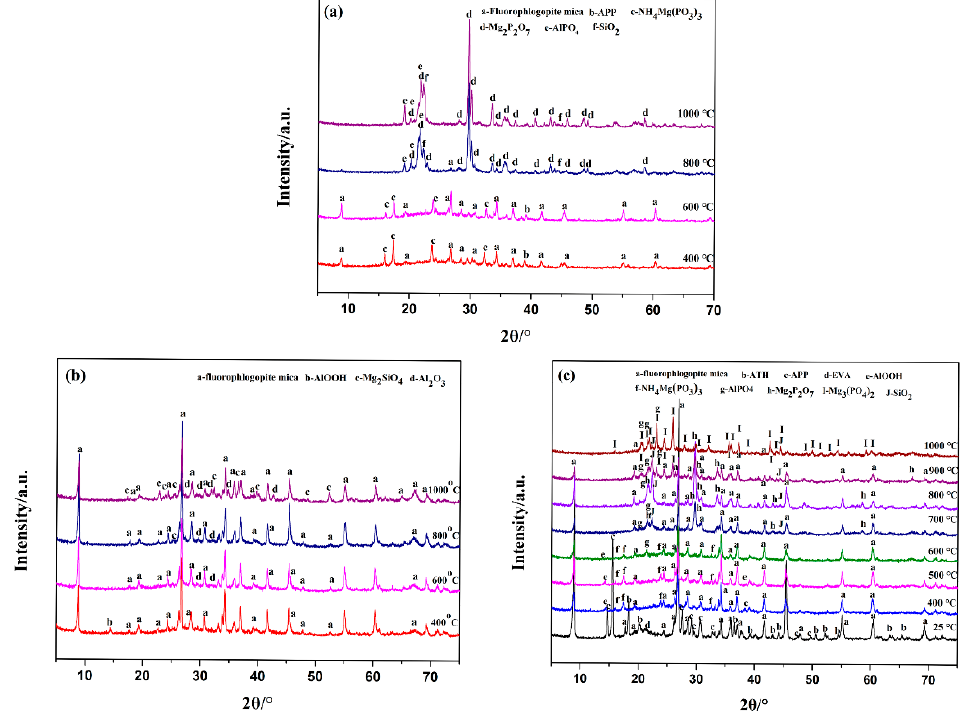
Figure 14. XRD spectra of sample EVA1 ( a ), sample EVA2 ( b ) and sample EVA5 ( c ) after sintered at different temperature.